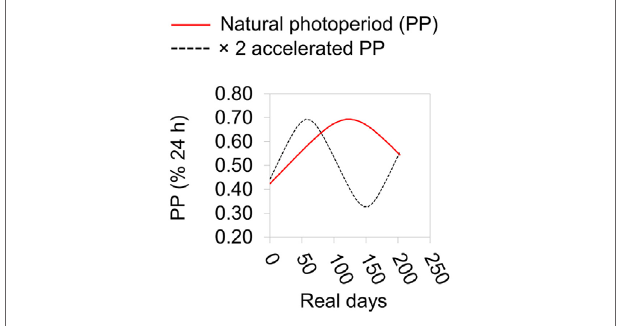
FigUre 1 | Summary of photoperiodic regimen during laboratory experiment. Photoperiod (PP) is expressed as a % of the 24 h cycle. The natural PP regimen is based on that at Cardiff,